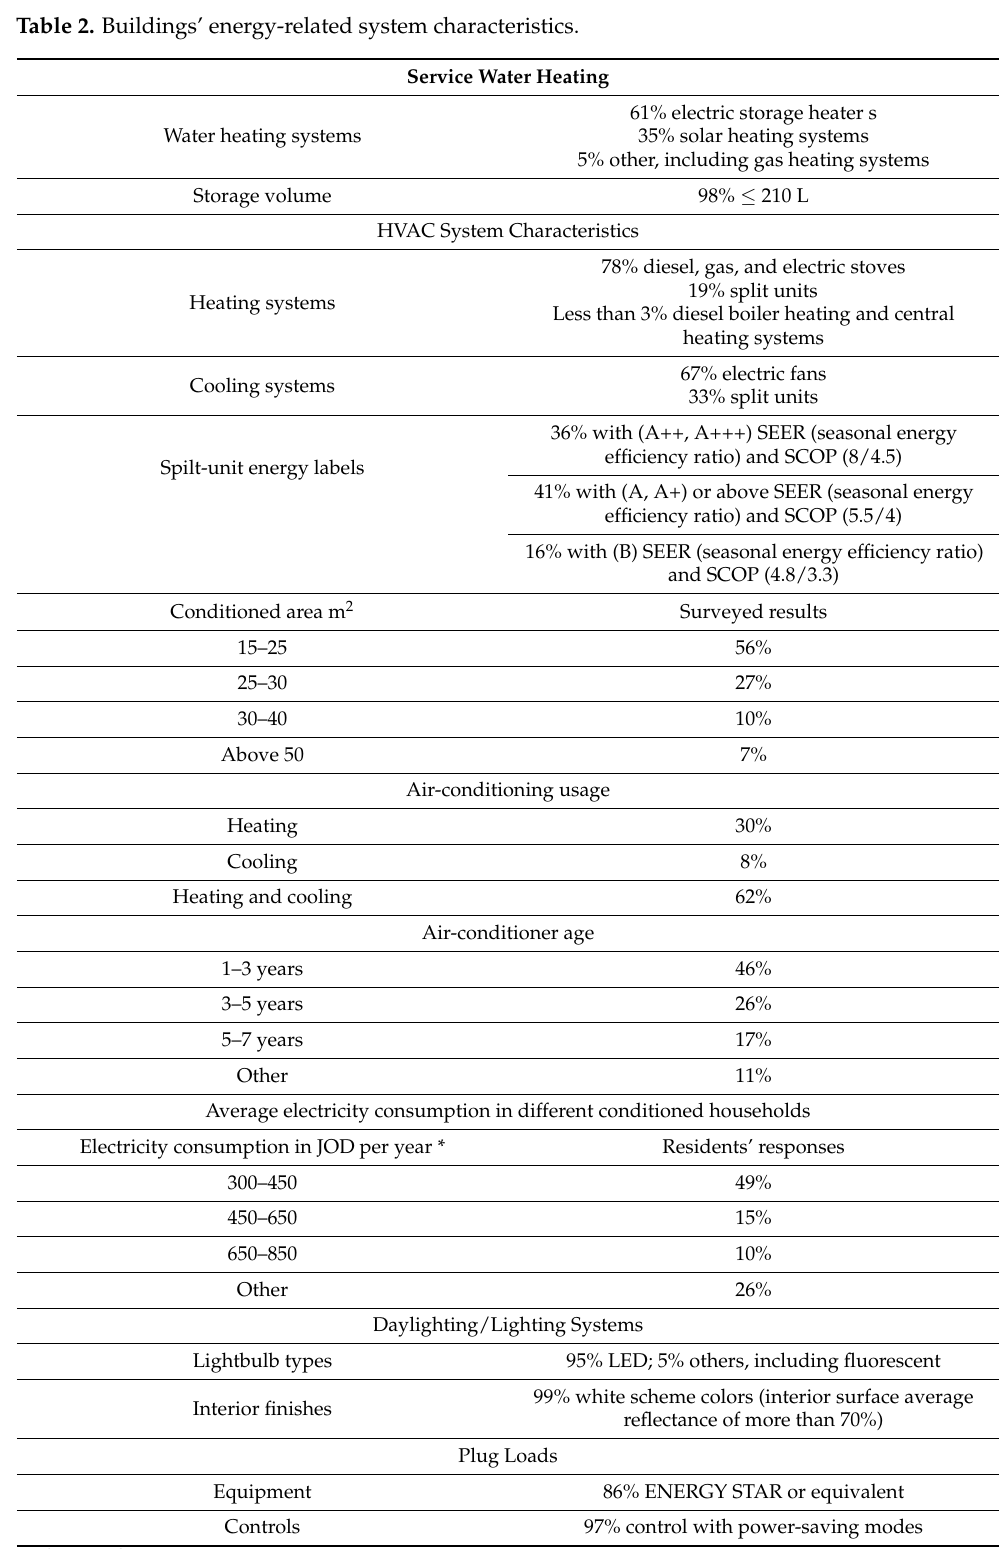
Table 2. Buildings’ energy-related system